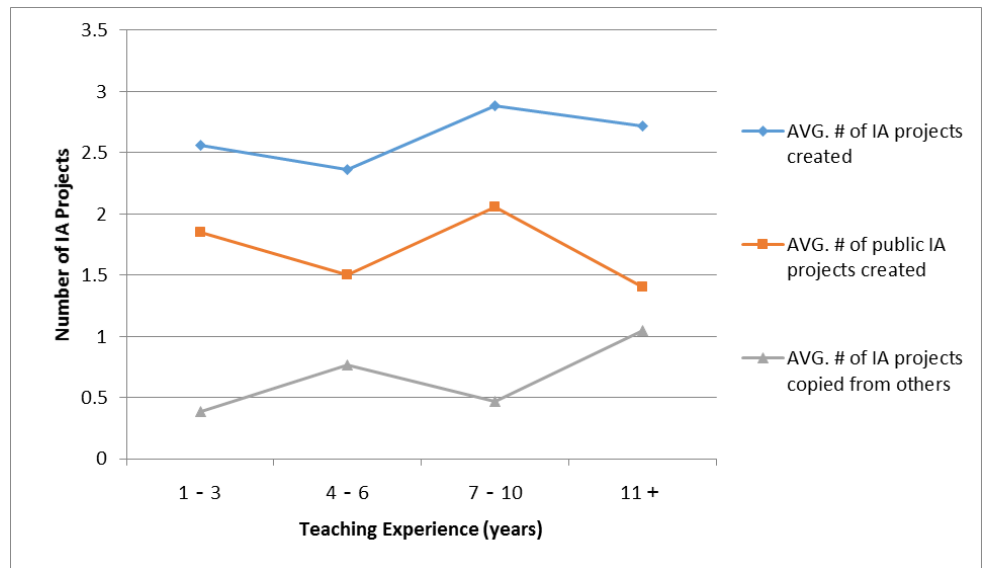
Figure 5. Teachers’ creation activity categorized by their teaching